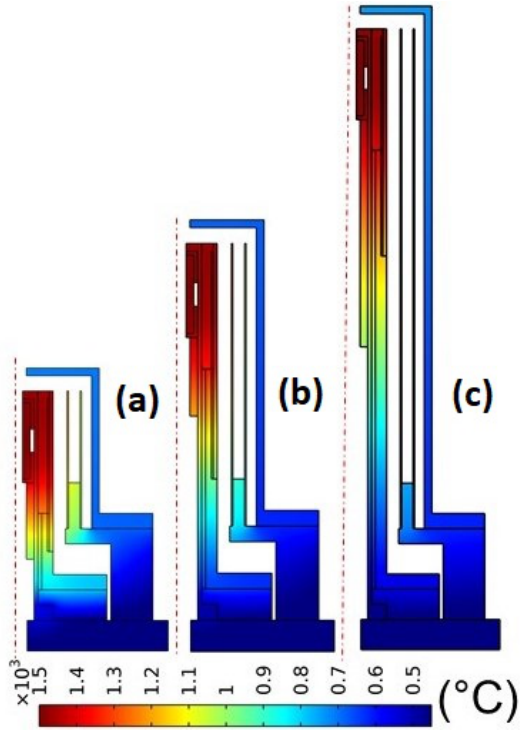
Figure 8. Temperature distribution: ( a ) Short coaxial–heater design; ( b ) Medium-length coaxial– heater design; ( c ) Long coaxial–heater